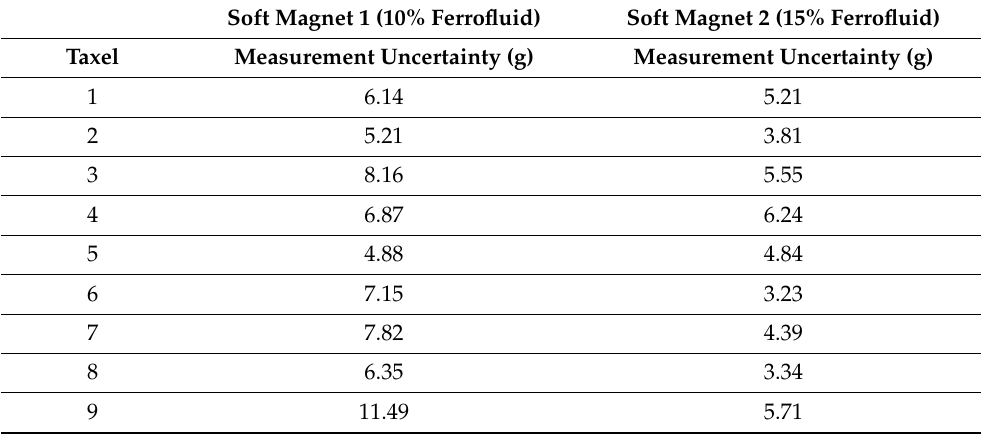
Table 3. Sensor uncertainties (2) for each taxel i from both soft